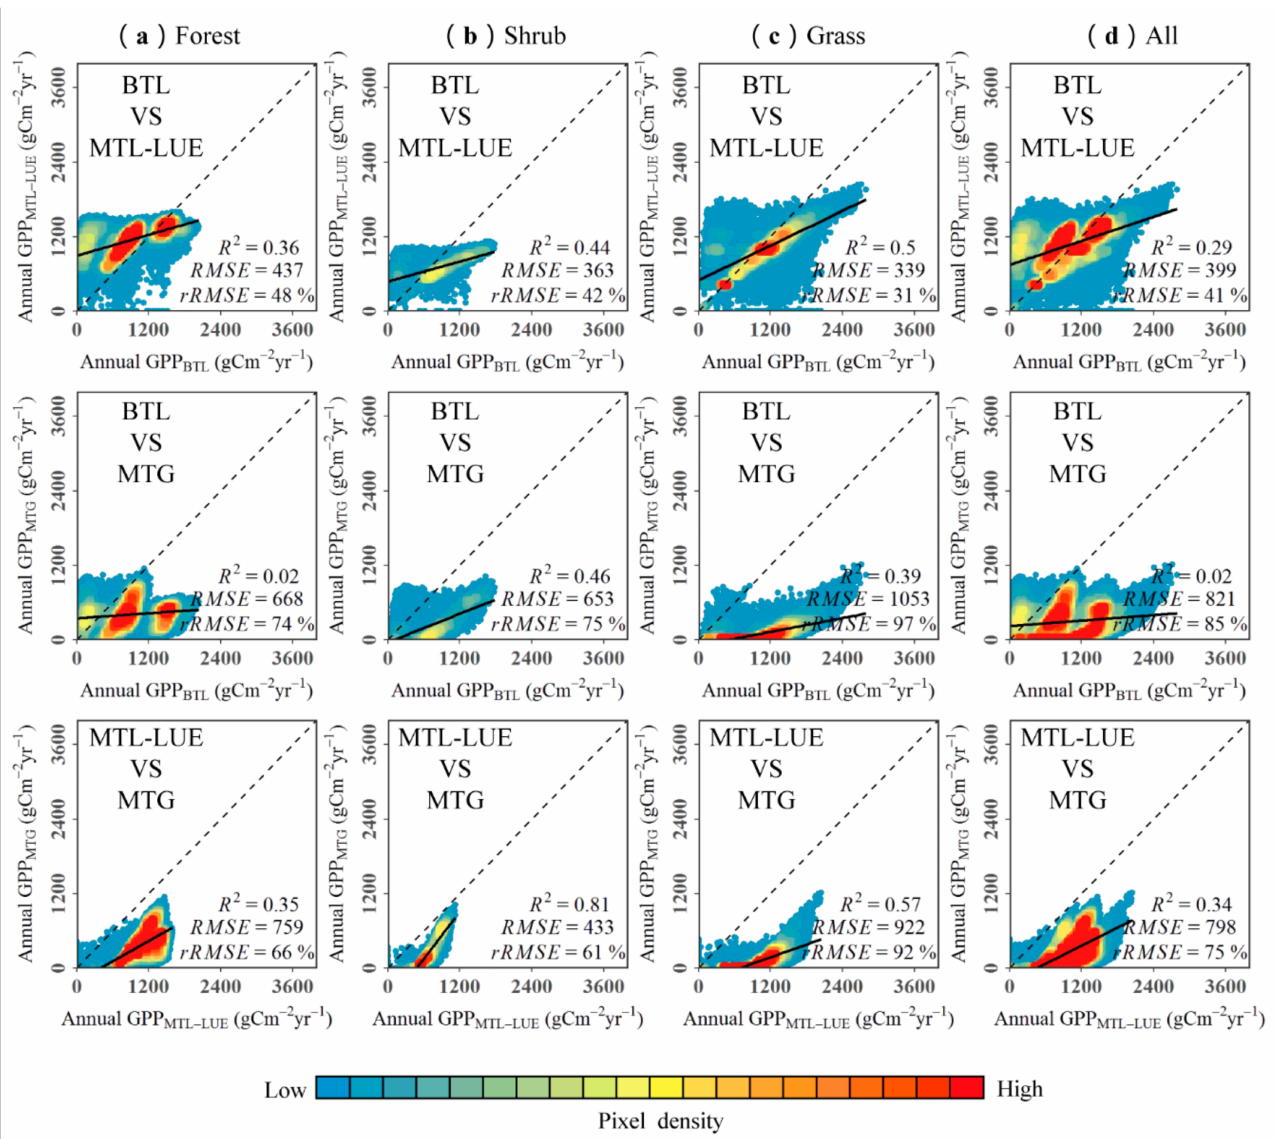
Figure 5. Comparisons between annual GPP BTL and GPP MTL-LUE (the first row), GPP BTL and GPP MTG (the second row), and GPP MTL-LUE and GPP MTG (the third row) in forest ( a ), shrub ( b ), grass ( c ), and all ( d )